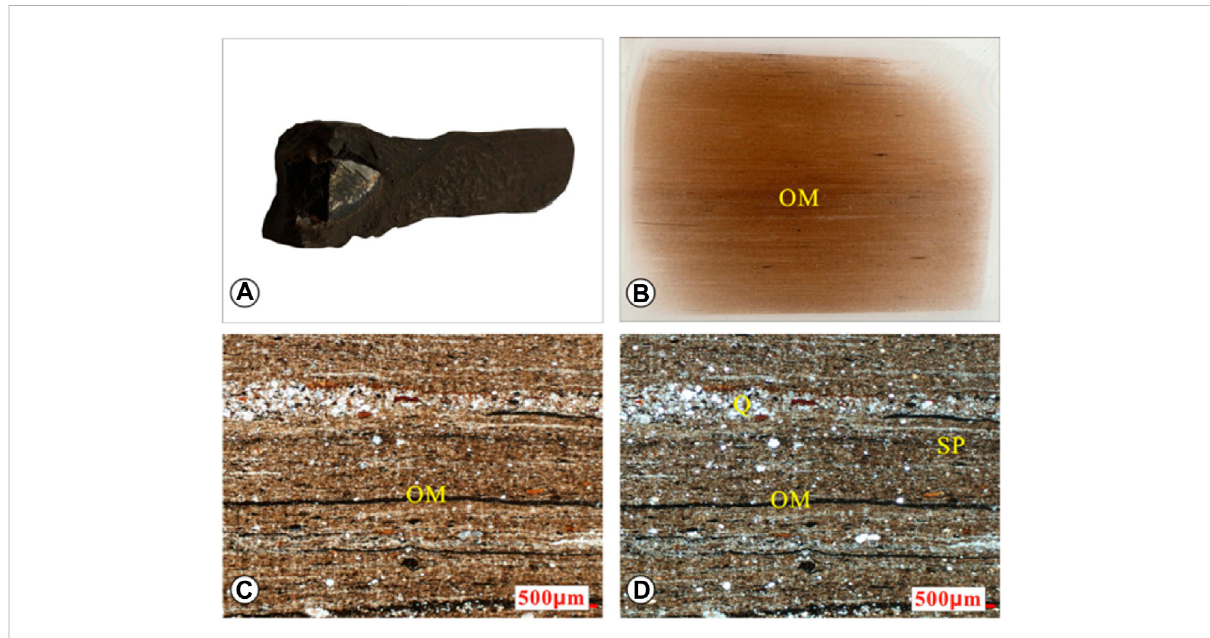
(Figure 2A). In this section, microscopically, the argillaceous structure and the layered structure can be seen (Figure